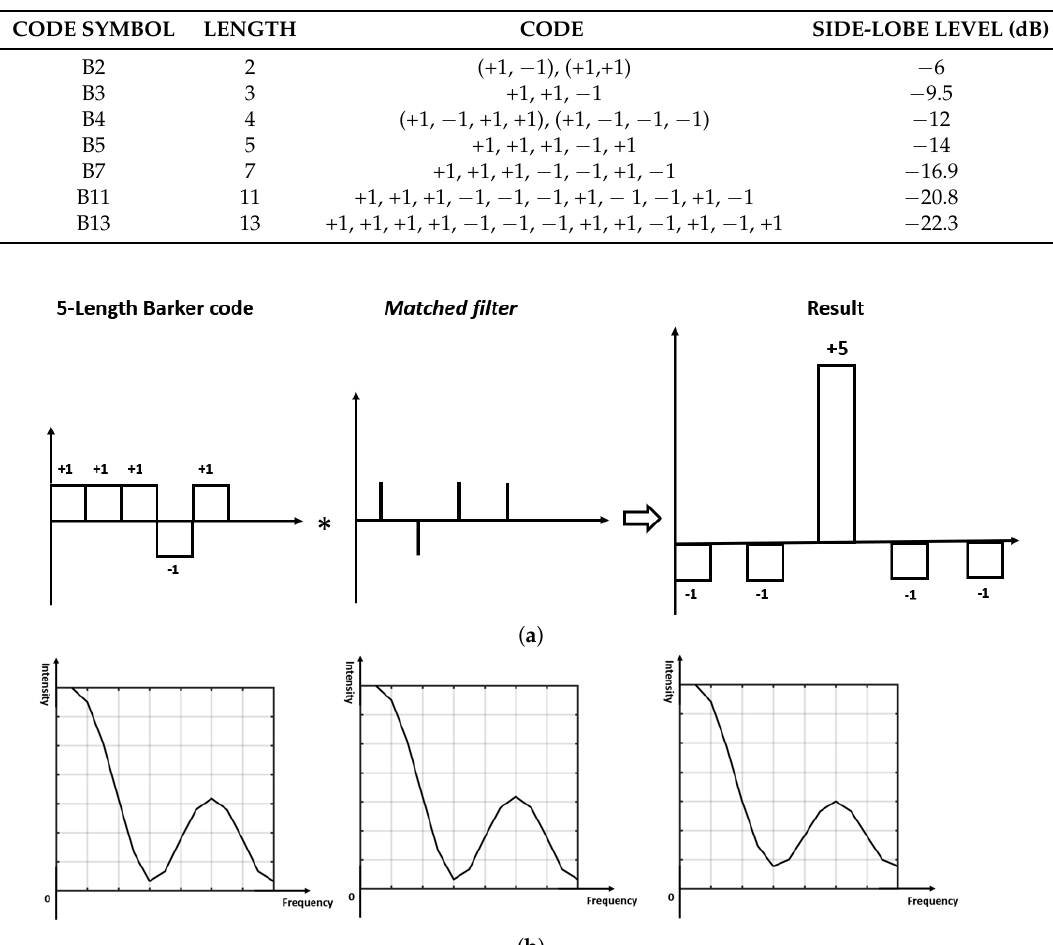
Table 1. Barker code of various lengths.